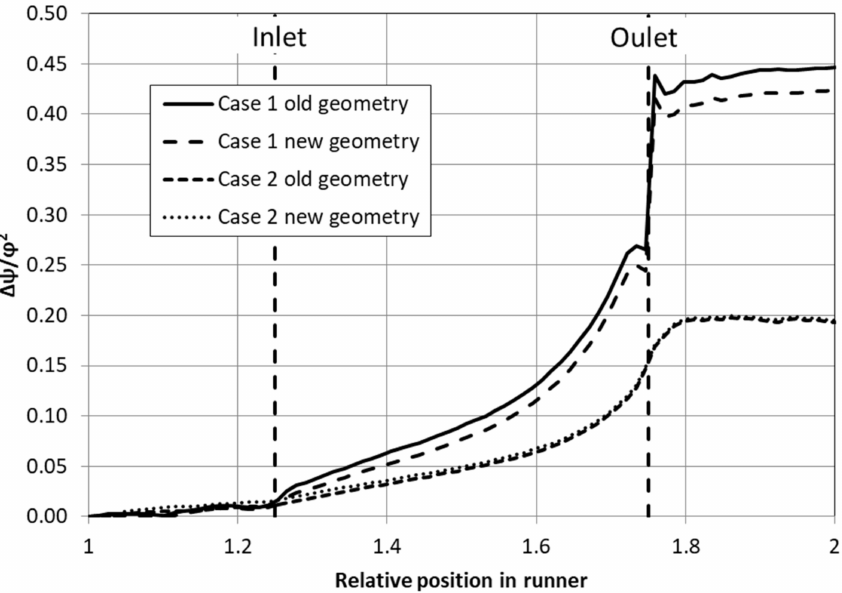
Figure 19. Efficiency loss coefficient as function of relative position in the runner of the case 1 and 2.